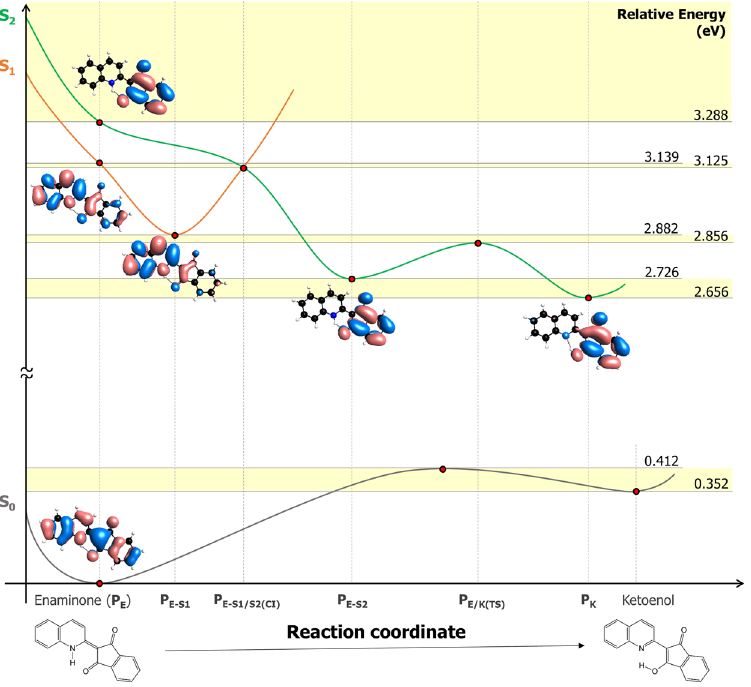
Figure 6. Schematic diagram of QPH species with relevant geometries and molecular orbitals in the S 0 , S 1 and